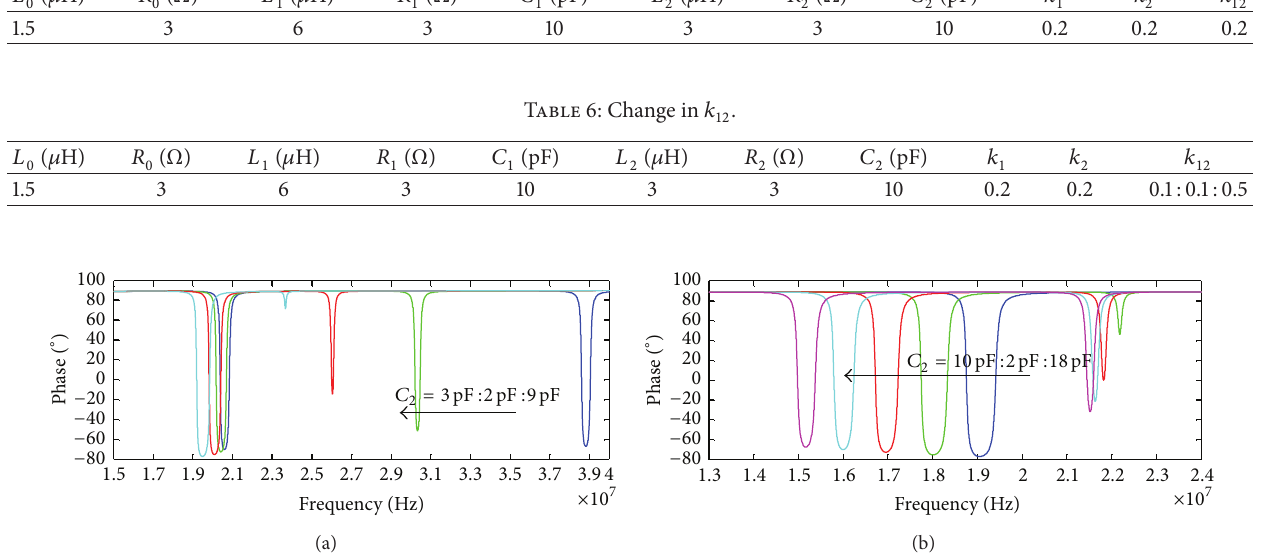
Figure 4: Simulation results upon changing 𝐶 2 from (a) 3pF to 9pF, (b) 10pF to 18 pF.